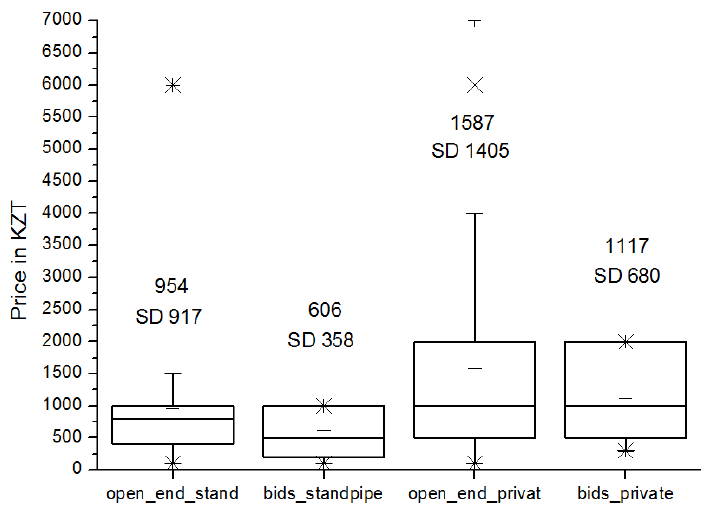
Figure 3. Boxplot of WTP for open-ended and bids answers both private connection and standpipe water (SD = standard